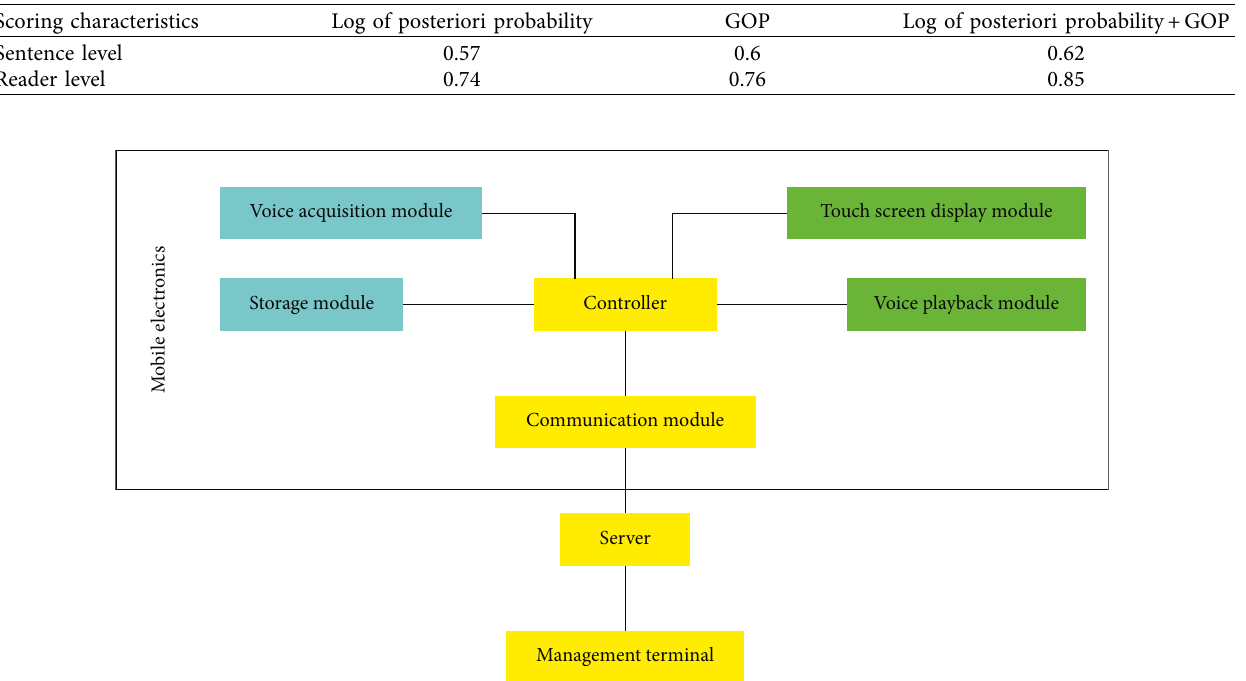
Table 2: The pronunciation accuracy.